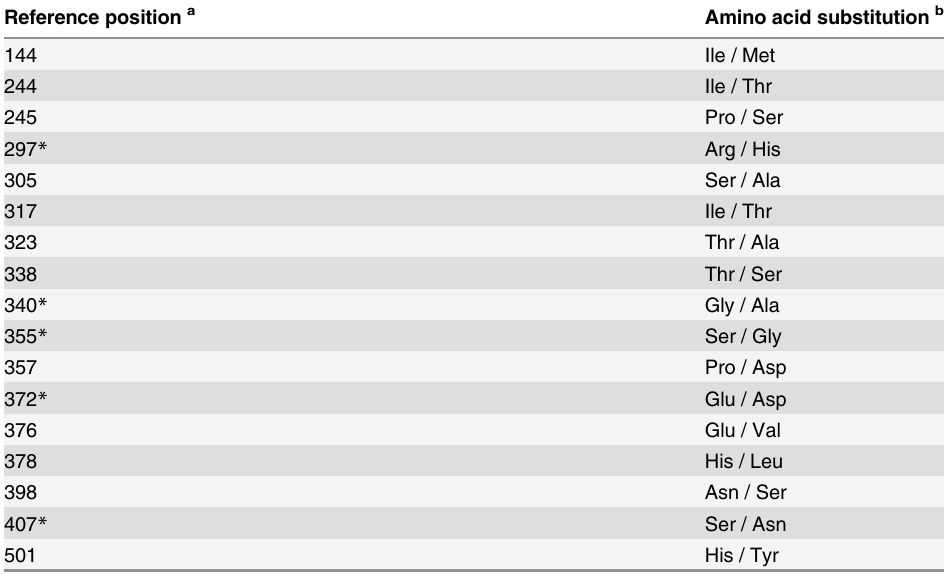
Table 1. Amino acid substitutions in the 58 translated GII.4 Den Haag 2006b